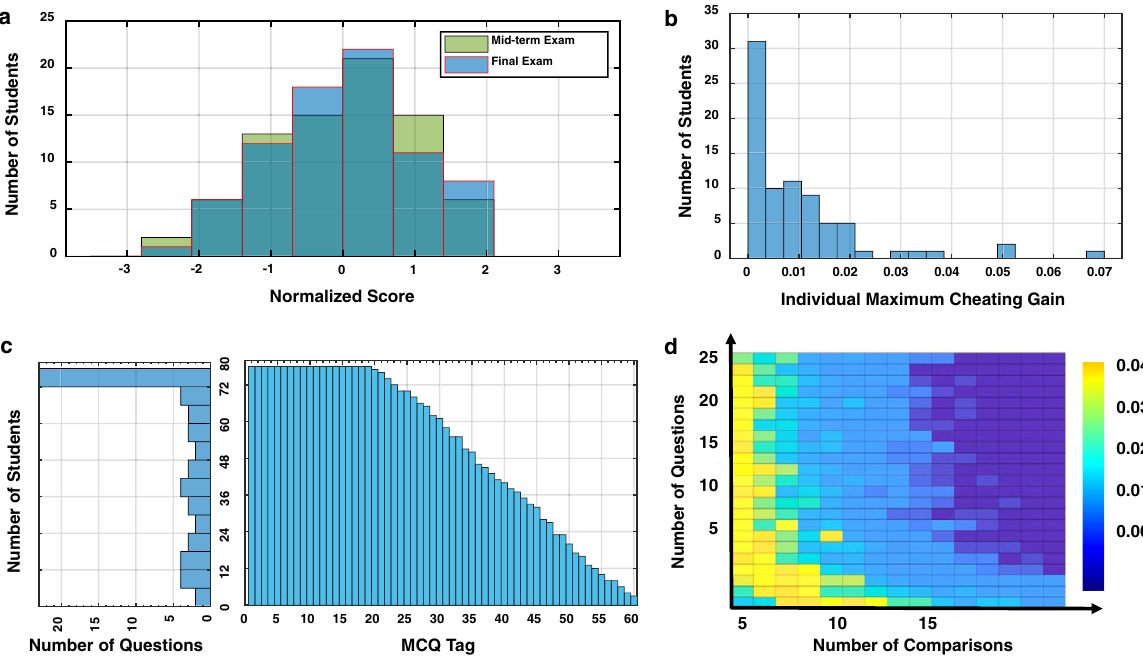
Fig. 2 Results of the fi nal exam. a The distribution of the fi nal exam scores (78 students, conducted on the DOT platform) in a normal ‘ bell' shape with insigni fi cant differences from the distribution of the midterm exam scores (before social distancing), which indicates the effectiveness of our DOT technology in collusion prevention. b With our optimized question assignment, the distribution of calculated maximum possible collusion gains in terms of percentage score showing the maximum collusion gains strictly below 7%. c The histogram of the size of a particular set of MCQs versus the number of students who received this set of questions on the left, and the distribution of this number versus the MCQ tag on the right, showing that not all student received the same questions. d Plotting q values against the number of comparisons and the number of questions to test the hypothesis that collusion resulted in students giving a signi fi cantly higher number of the same incorrect answers. As all q values are below the signi fi cance level of 0.05, we conclude that no signi fi cant collusion